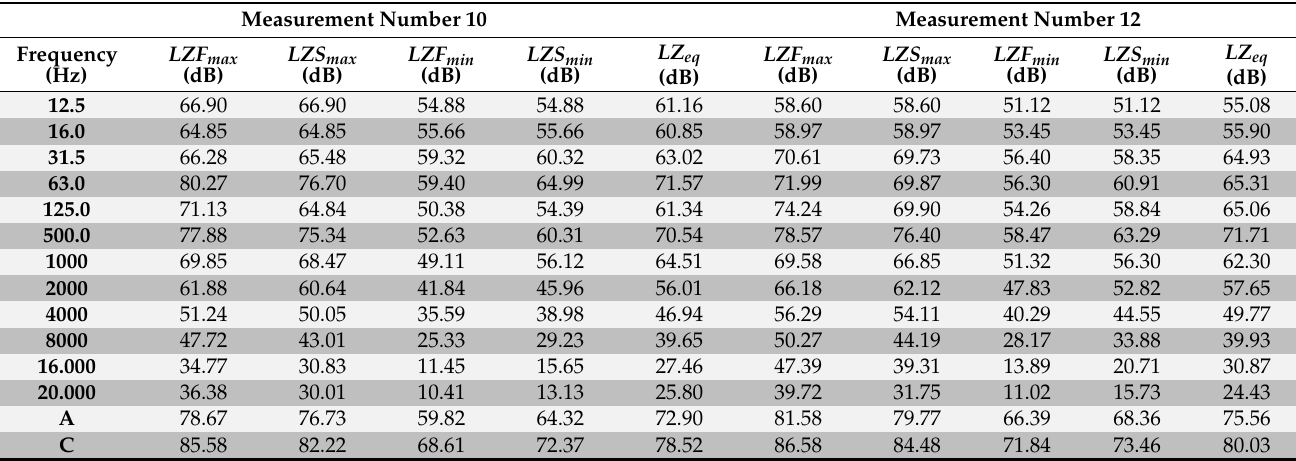
Table 3. Values of noise levels in the 1/3 octave frequency spectrum band at B1H of selected